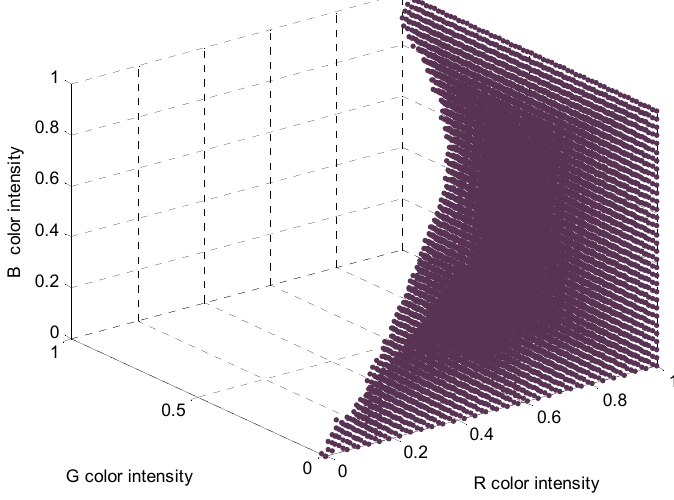
Figure 4. Red peach segmentation LUT obtained from linear color